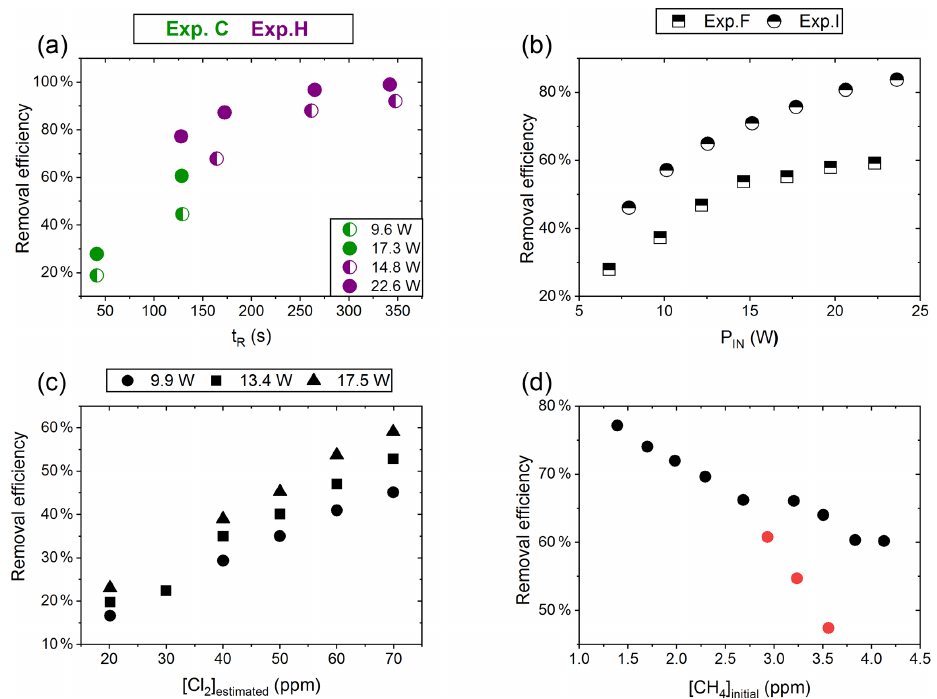
Figure 4. (a) RE% of methane plotted against t R (s). The result originates from the two experiments C (green) and H (violet). The experiments have different settings in P IN , [CH 4 ] and [Cl 2 ]. (b) RE% of methane plotted against P IN (W). The results are from the two experiments F (square) and I (triangle), which have different [CH 4 ] settings. (c) The panel presents the methane RE% as a function of the chlorine mixing ratio for exp. E. Step 1, at 30ppm [Cl 2 ], is an example of start-up deviation; therefore, it is removed. The points represent the three different P IN of the photochemical device. (d) The removal efficiency RE% during exp. G of methane is displayed as a function of the initial methane concentration with the remaining fixed parameters such as [Cl 2 ] mixing ratio, t R and P IN input. The three red points in the figure represent steps suffering from start-up